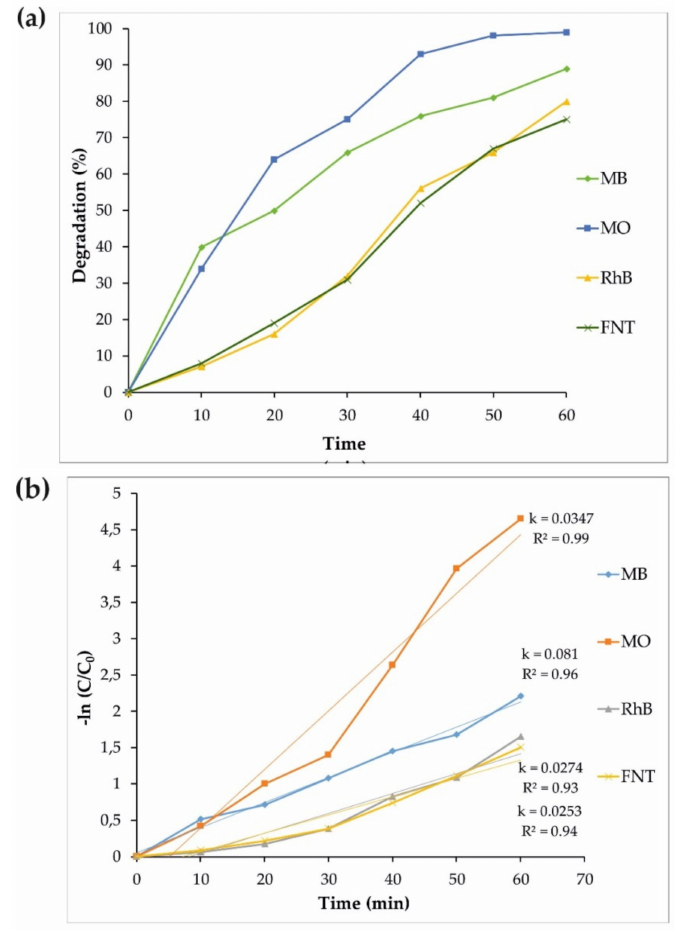
Figure 7. ( a ) The photocatalytic degradation of MB, MO, RhB, and FNT by the S4 sample under UV light irradiation. ( b ) The pseudo-first-order kinetics of the MB, MO, FNT, and RhB degradation by the S4